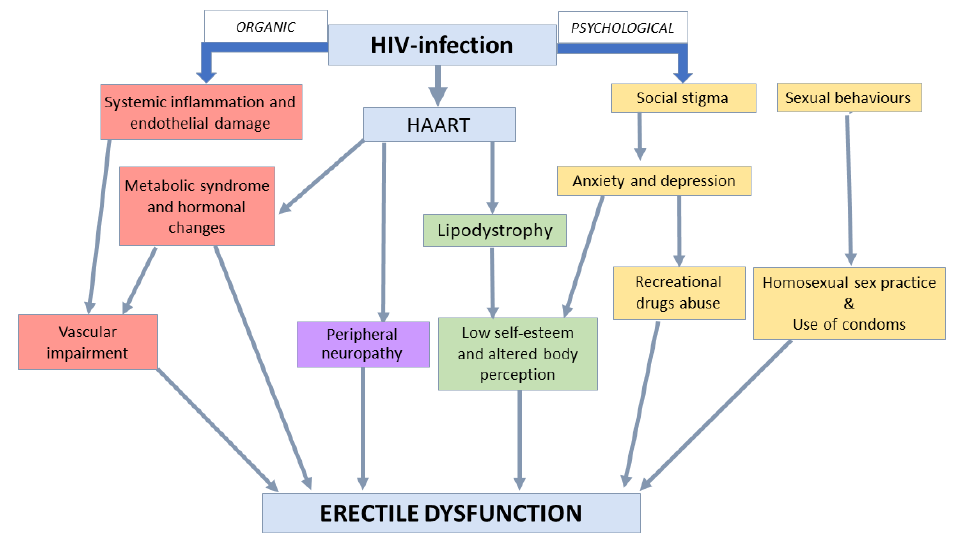
Figure 2. Organic and psychological factors involved in erectile dysfunction pathogenesis in men with HIV. Abbreviations: HAART: Highly Active Anti-Retroviral Therapy.